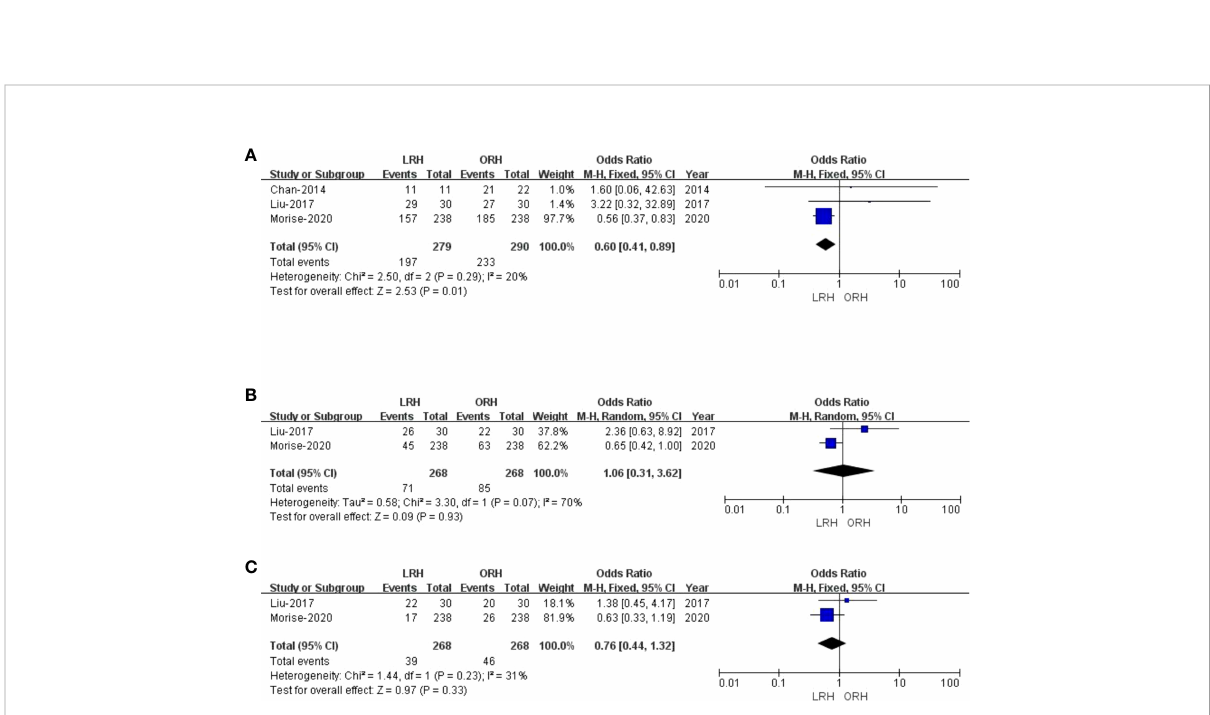
FIGURE 4 Forest plot of comparison of LRH versus ORH for the overall survival rate of survivors. (A) , Forest plot for 1-year overall survival time rate; (B) , Forest plot for 3-year survival time rate; (C) , Forest plot for 5-year survival time